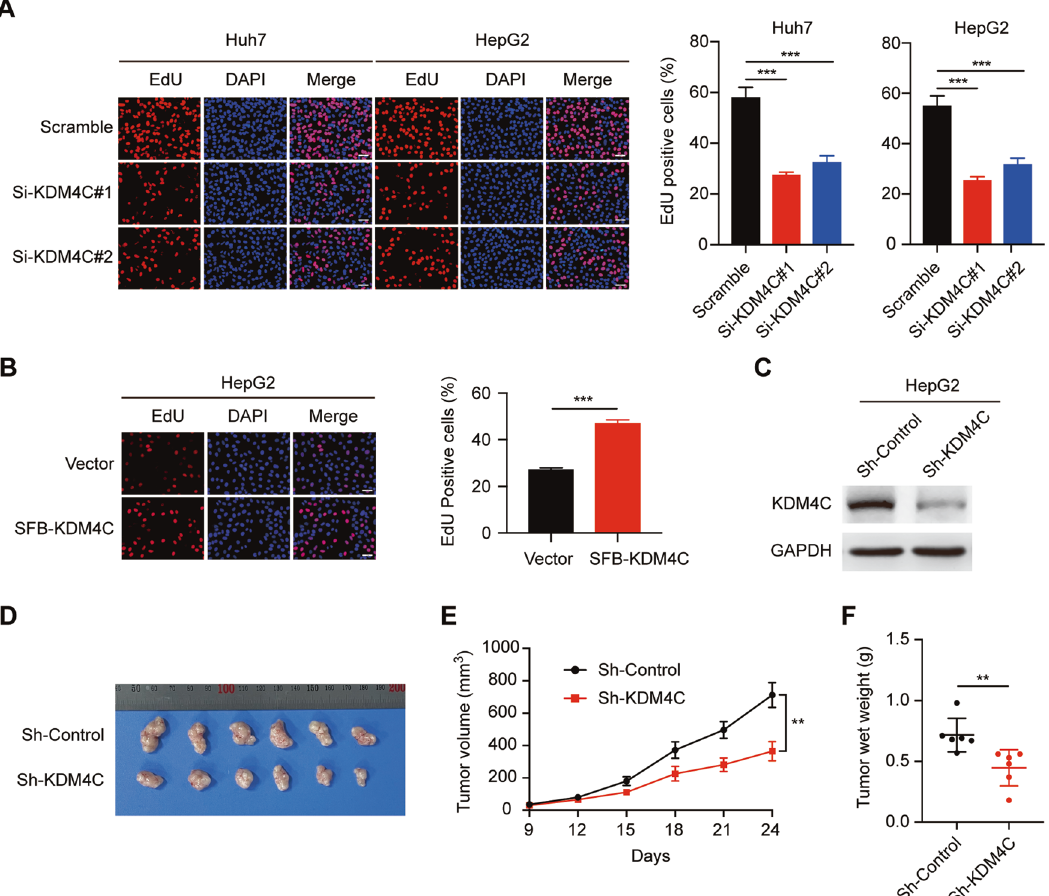
Fig. 2 KDM4C knockdown inhibits HCC tumor growth in vivo. A , B Left panel: cell proliferation ability was examined by EdU assay. Right panel: the Edu-positive cell rate in each group was calculated ( n = 3). Scale bar, 50 μ m. C KDM4C was effectively knocked down using KDM4C- targeting shRNAs in HepG2 cells ( n = 3). D Images of subcutaneous xenograft tumors (six mice/group). E The tumor volume was measured and calculated every three days (six mice/group). F The wet weight of the tumors (six